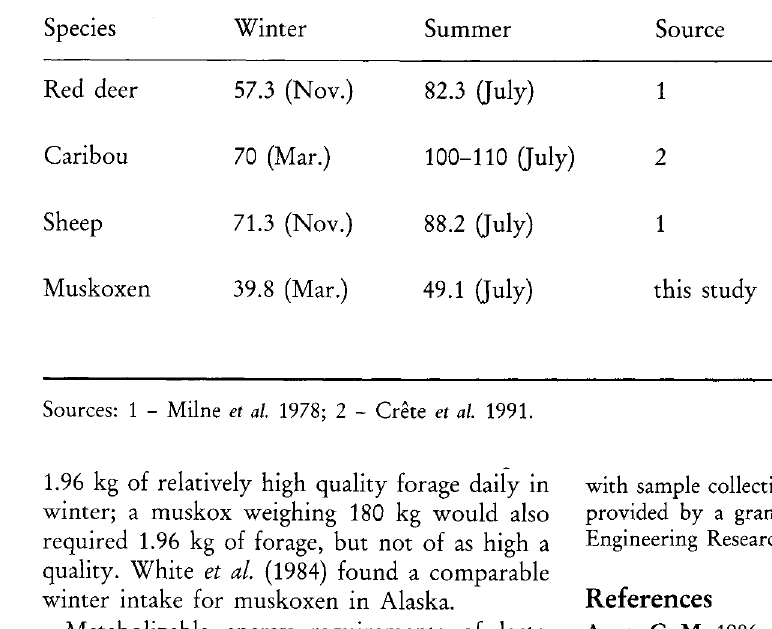
Table 3. Voluntary food intake of selected ruminant species in winter and summer, gDM/kgBW- 75